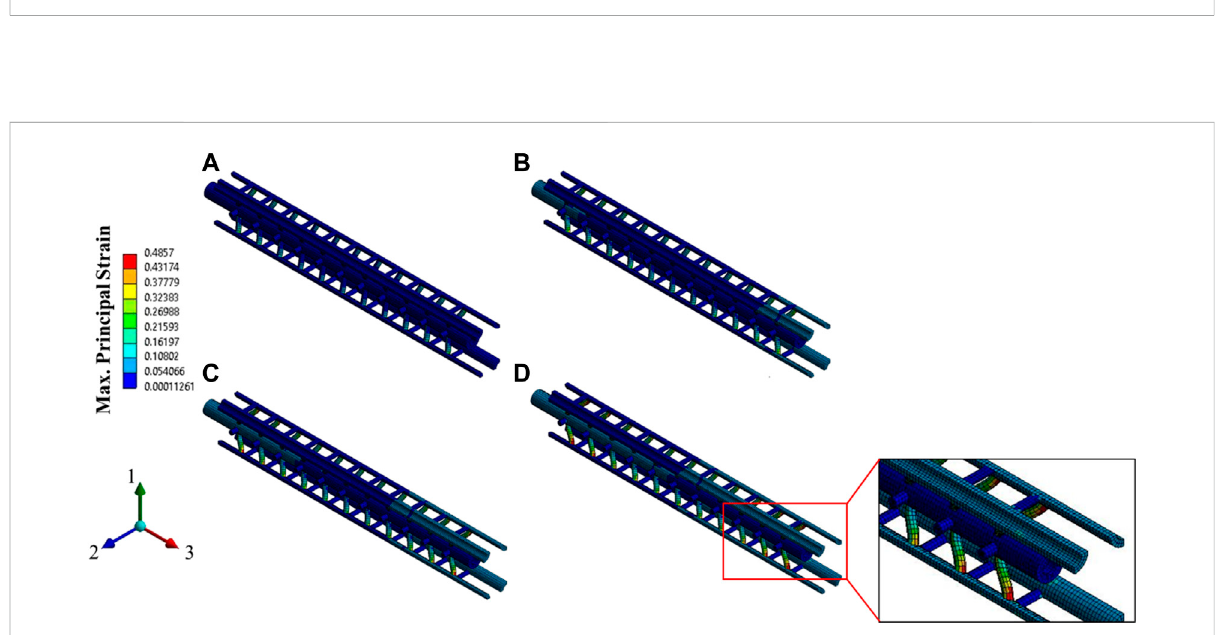
FIGURE 16 Contourplotofthemaximumprincipalstrain(elementalmean)forthestrainrateof5/sec,at (A) 2.5%strain, (B) 5%strain, (C) 7.5%strain,and (D) 10% strain (the matrix is hidden to show the strain on the Tau